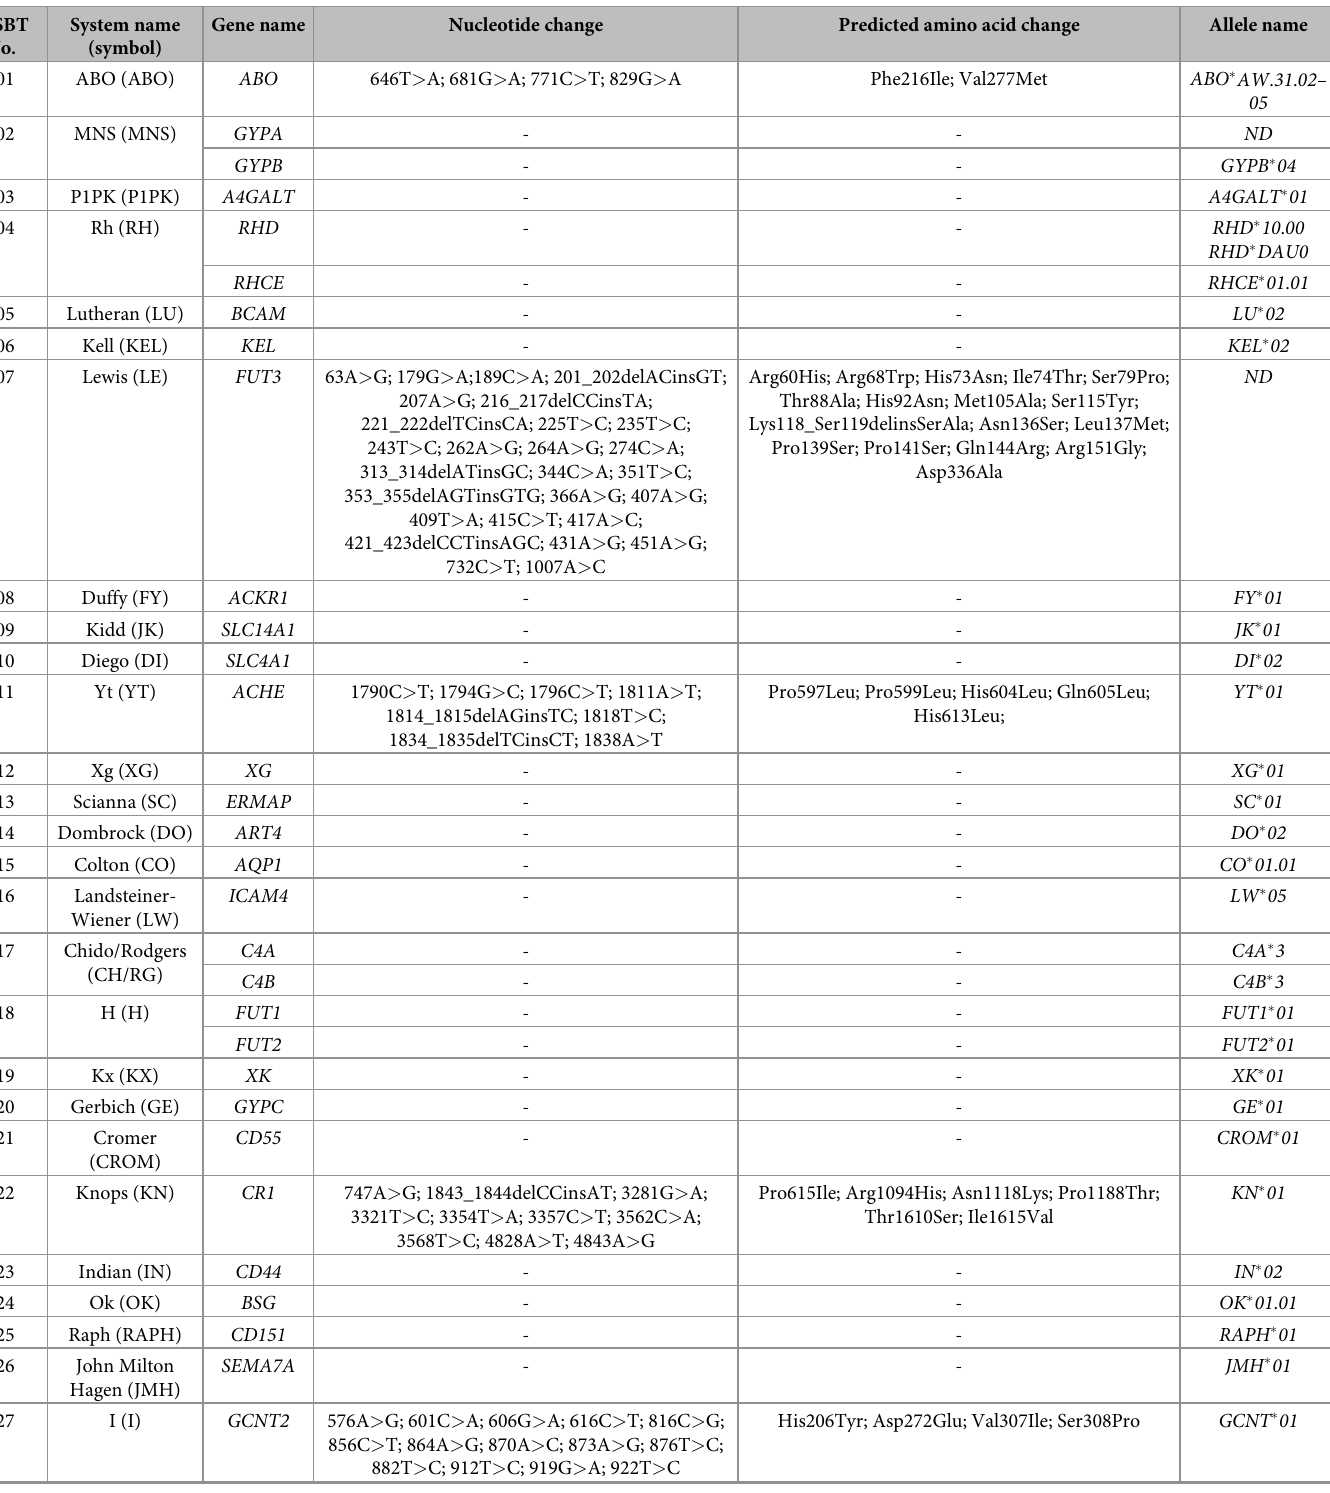
Table 2. Prediction of various blood group systems in one representative data compared to conventional cDNA sequences analyzed using CLC Genomics Workbench. ISBT